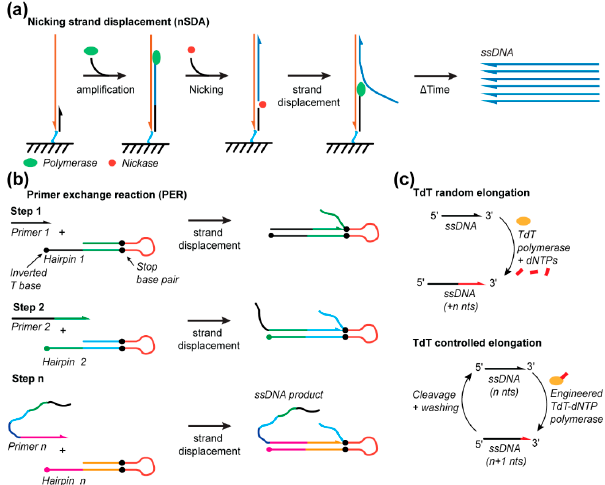
Figure 6. Emerging enzymatic methods for ssDNA synthesis. ( a ) Nicking strand displacement (nSDA) technique. ( b ) Primer exchange reaction for programmable synthesis of ssDNA. ( c ) Terminal deoxynucleotidyl transferase methods to elongate (random) ssDNA or for de novo synthesis (controlled elongation).